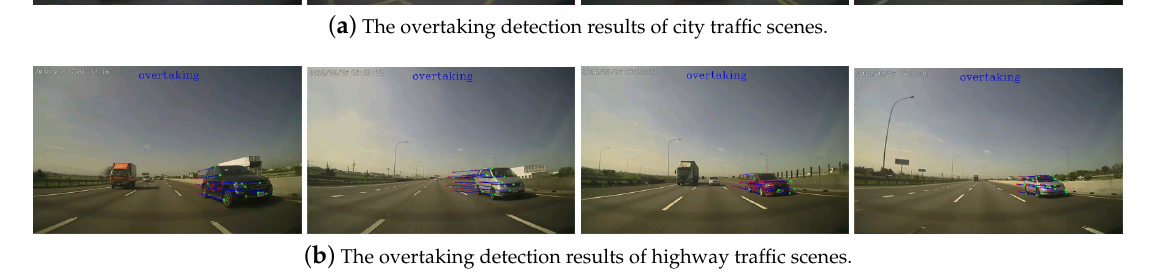
( b ) The overtaking detection results of highway traffic scenes.